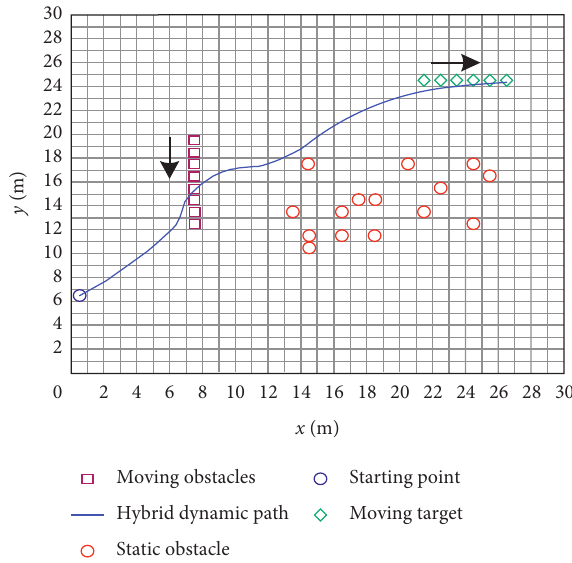
Figure 6: Path planning with dynamic obstacles and moving